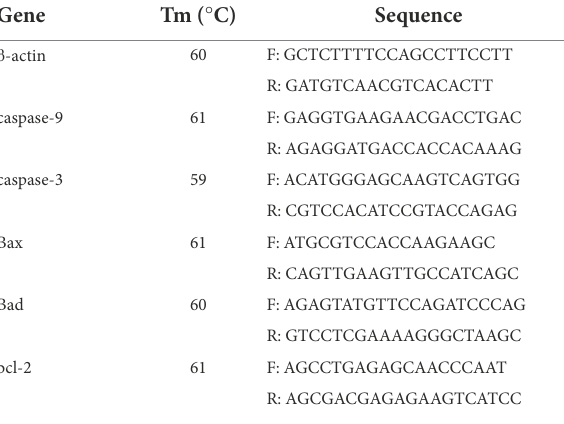
TABLE 1 Primer sequences for RT-qPCR in the prefrontal